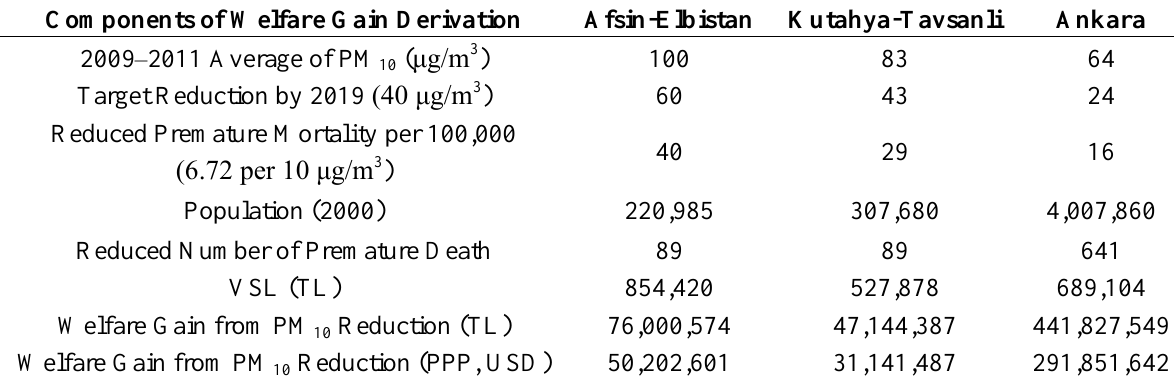
Table 13. Estimated VSL Application to Air Pollution Policy